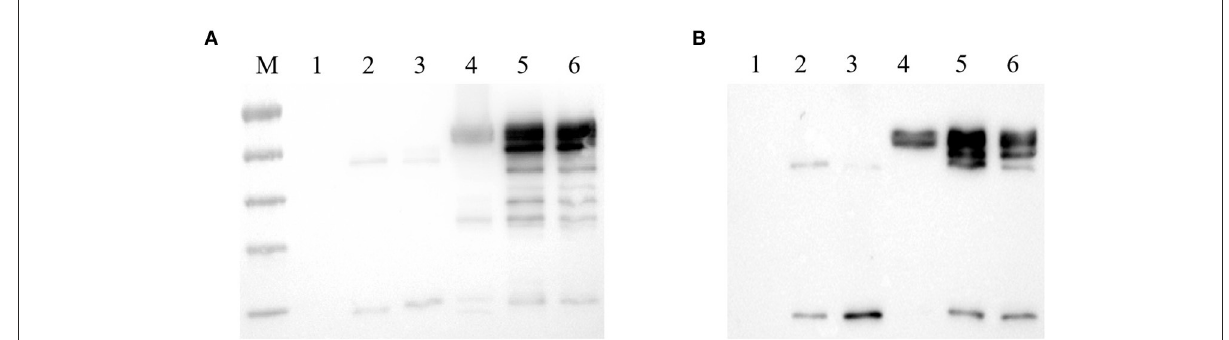
FIGURE3 mAbs 3G6 and 6F10 efficiently immunoprecipitated Fiber-1 of DAdV-3. (A) mAbs 3G6 and 6F10 immunoprecipitated Fiber-1 in LMH cells transfected with pcDNA3.1-Fiber-1. Lane 1 and 4: Western blot assay for the lysates of LMH cells transfected with pcDNA3.1 and pcDNA3.1-Fiber-1, respectively. Lanes 2 and 3: Western blot assay for the lysates of LMH cells transfected with pcDNA3.1 immunoprecipitated by mAb 3G6 and 6F10, respectively. Lanes 5 and 6: Western blot assay for the lysates of LMH cells transfected with pcDNA3.1-Fiber-1 immunoprecipitated by mAb 3G6 and 6F10, respectively. (B) mAbs 3G6 and 6F10 immunoprecipitated Fiber-1 in LMH cells infected with DAdV-3. Lane 1 and 4: Western blot assay for the lysates of LMH cells infected without and with DAdV-3, respectively. Lanes 2 and 3: Western blot assay for the lysates of LMH cells without the infection of DAdV-3 immunoprecipitated by mAb 3G6 and 6F10, respectively. Lanes 5 and 6: Western blot assay for the lysates of LMH cells infected with DAdV-3 immunoprecipitated by mAb 3G6 and 6F10, respectively.